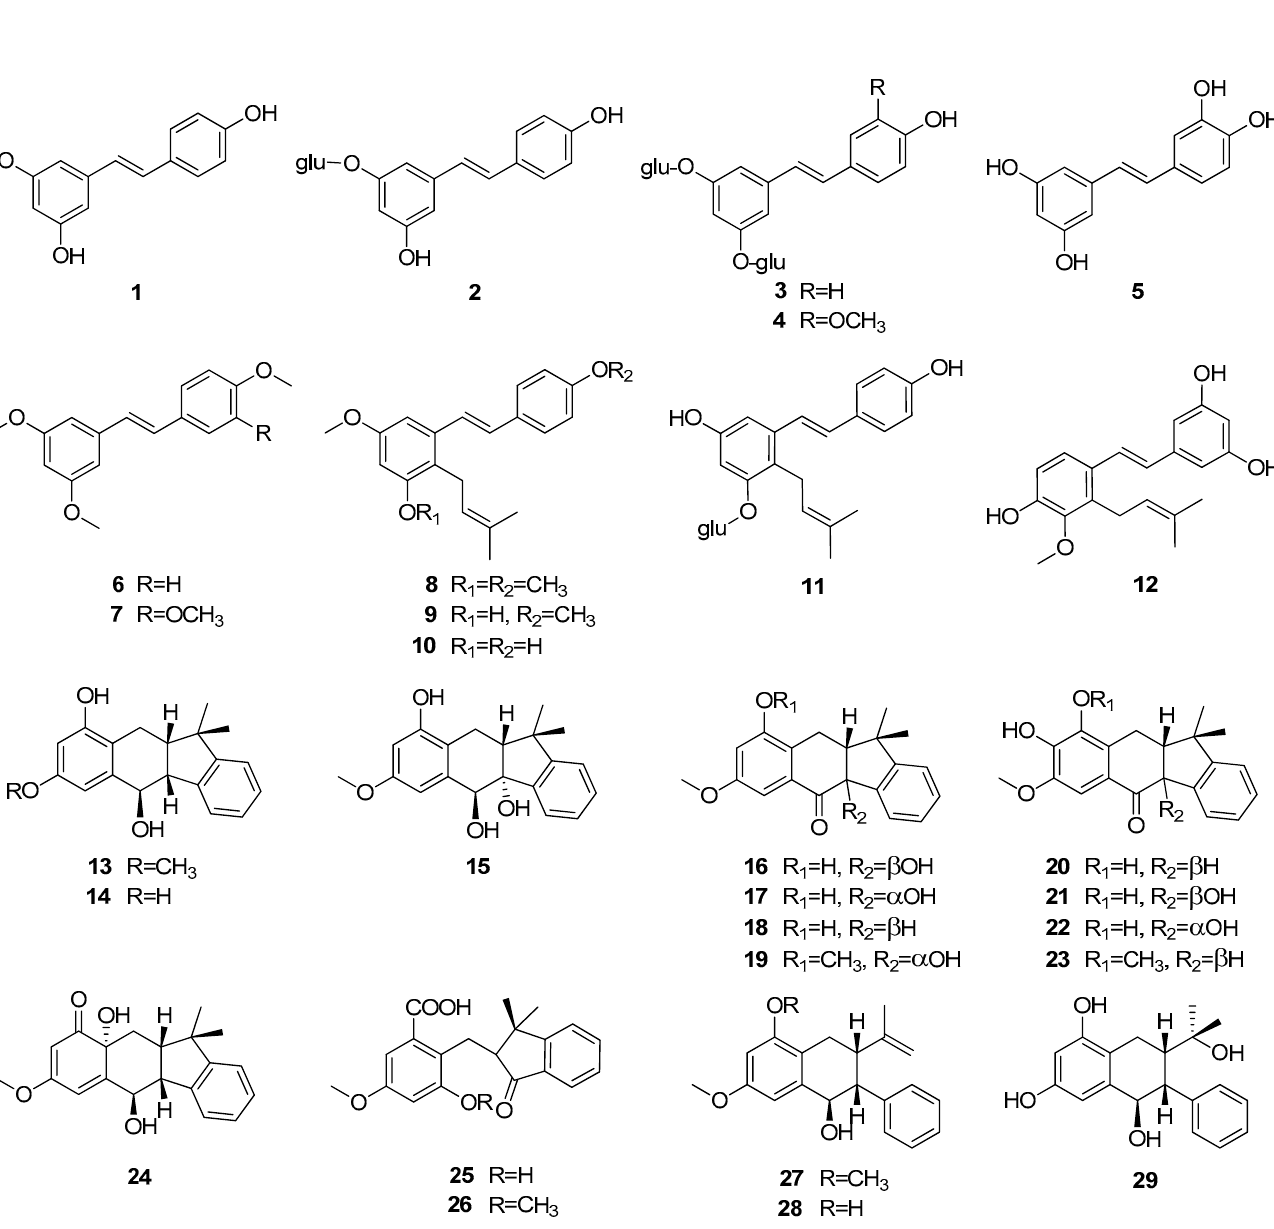
Figure 3. Stilbene monomers isolated from Cyperaceae species (glu = glucose) . trans -Resveratrol ( 1 ) is the common constituent of most of the oligomers isolated from sedges. Scirpusins A ( 31 ) and B ( 32 ) are abundant stilbene dimers in Scirpus and Cyperus species [14,15,26,45] (Figure 4). Scirpusin A ( 31 ) is the heterodimer of trans - resveratrol ( 1 ) and piceatannol ( 5 ), while scirpusin B ( 32 ) is evolved through the connection of two resveratrol units. ε -Viniferin ( 30 ), a resveratrol dimer, occurs mainly in Carex species ( C. appressa var. virgata , C. fedia var. miyabei , C. kobomugi , and C. pumila ) but it is a biogenetically important intermediate of stilbene oligomers in Cyperaceae species. Longusone A ( 33 ), isolated from Cyperus longus , is the only norstilbene dimer identified from Cyperaceae family; it contains a tropilene skeleton [26].